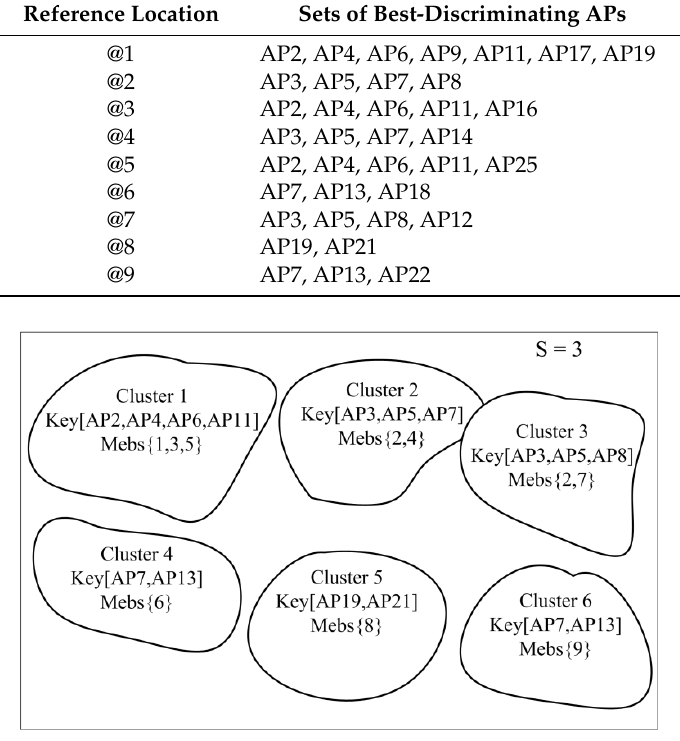
Figure 11. Clustering results with S = 3. Mebs, members.